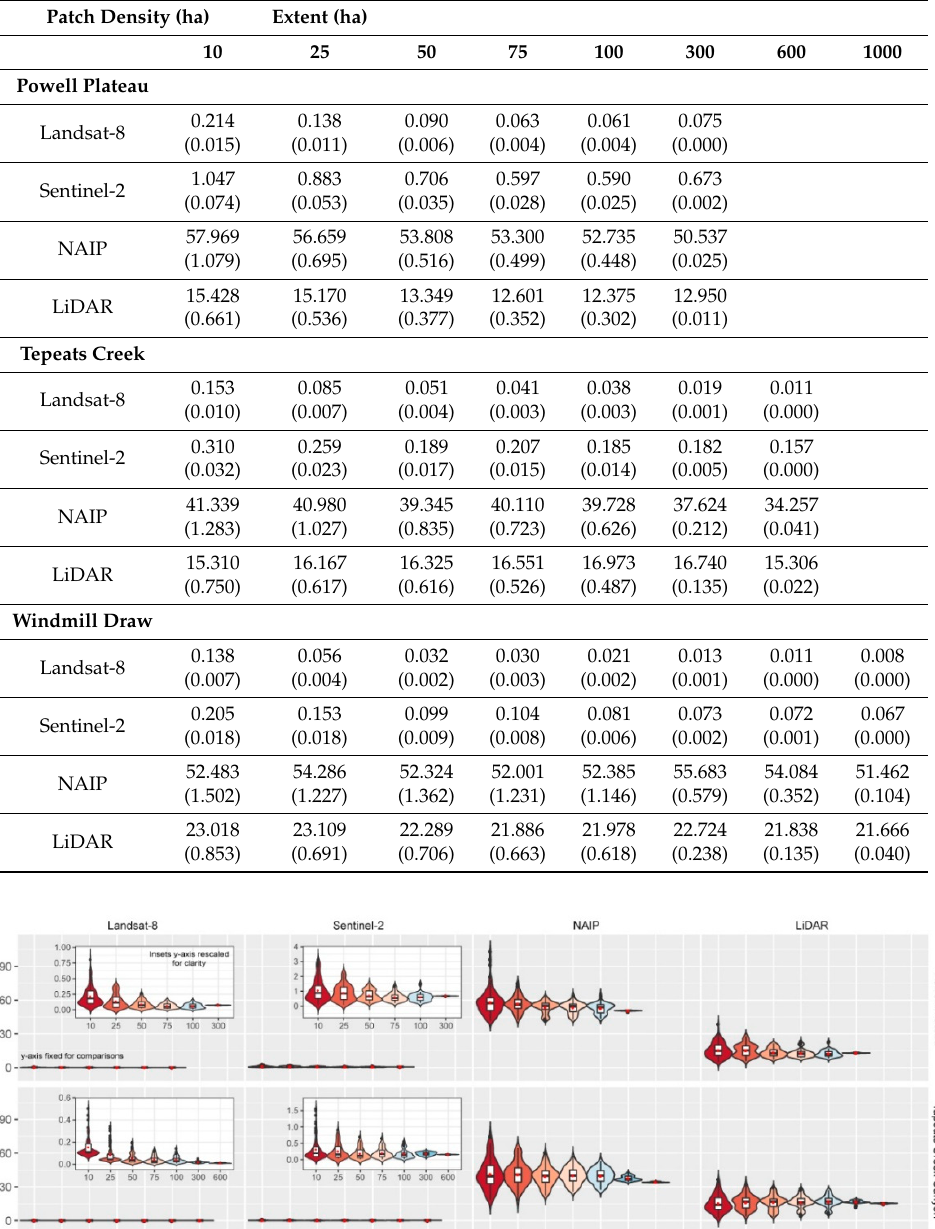
Table 3. Patch density (PD), the average number of patches of canopy cover on each landscape, delineated by each data product (Landsat-8 30 m, Sentinel-2 10 m, NAIP 1 m, LiDAR 1 m) and across multiple spatial extents. Mean values and standard error (SE) are shown.